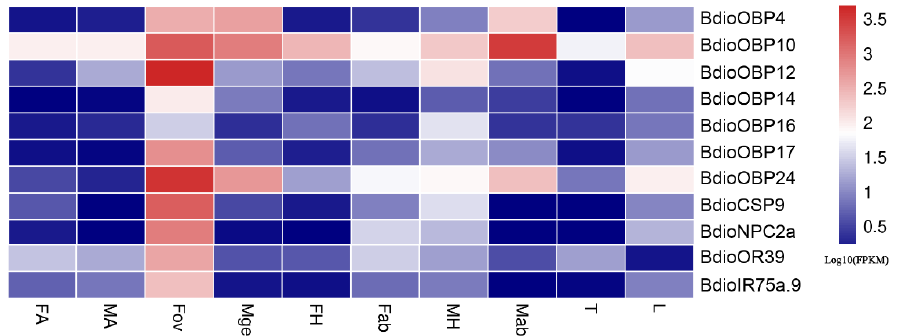
Figure 10. Expression profiles of ovipositor-biased chemosensory genes in B. dioryctriae with Scheme 0. &|log2 (fold change) > 2 when Fov vs. other nine tissues. FA and MA: female and male antennae; Insects 2022 , 13 , x FOR PEER REVIEW FH and MH: female and male heads without antennae; Fab: female abdomens without ovipositors and digestive tracts; Fov: female ovipositors; Mge: male genitalia; Mab: male abdomens without genitalia and digestive tracts; T: male and female thoraxes; L: male and female legs.